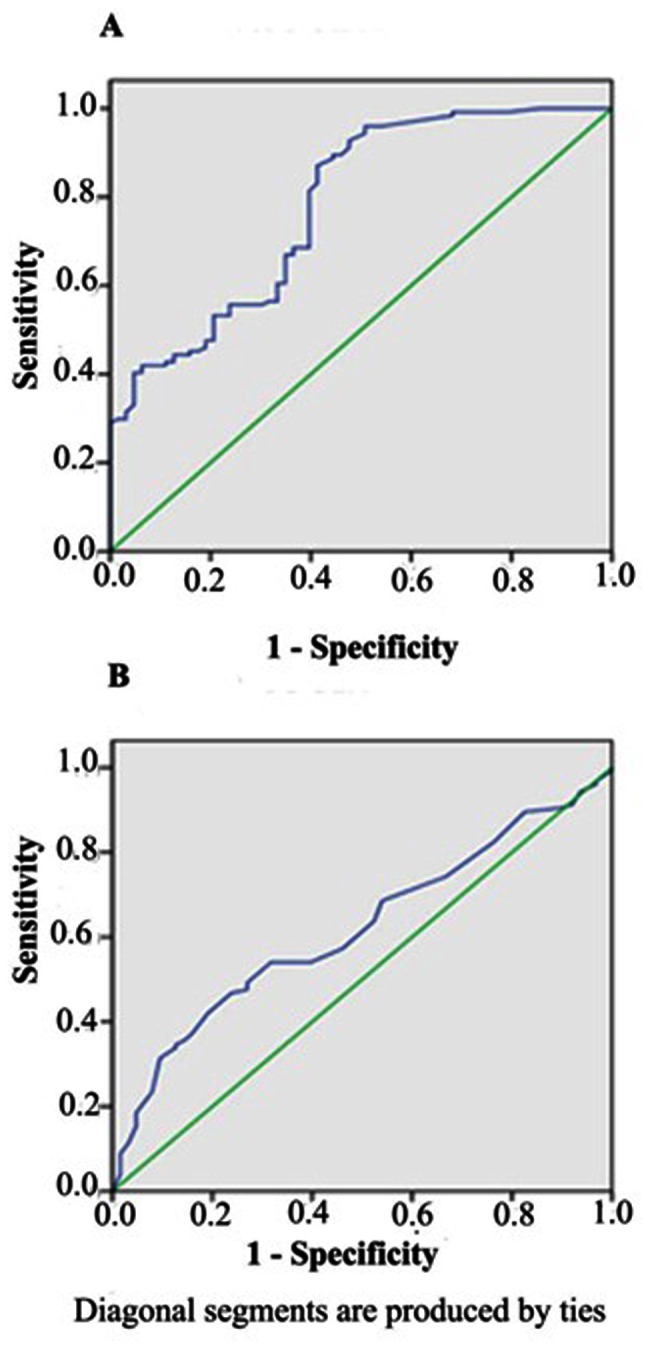
ROC curves of selected variables as a predictor of recurrent pregnancy loss.A: HHcy (AUC = 0.778); B: HOMA2-IR (AUC = 0.619). HHcy = hyperhomocysteinemia; HOMA2-IR = homeostasis model assessment of insulin resistance), AUC = area under the curve.